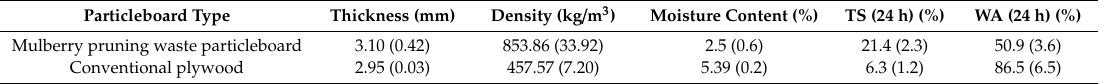
Table 2. Physical properties of mulberry and conventional plywood.